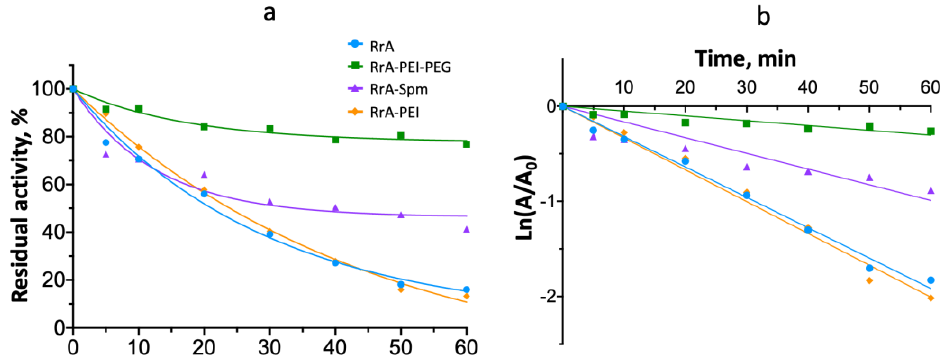
Figure 8. Trypsinolysis curves ( a ) and semi-log dependences ( b ) of the residual activity of native RrA and its conjugates on the incubation time at 37 ◦ C. The concentration of L-asparaginase in the samples was 1 mg/mL; the concentration of trypsin was 0.0025 mg/mL; PBS pH 7.5. Table 7. Inactivation constants in the trypsinolysis reaction for native RrA and its conjugates. RrA Preparation